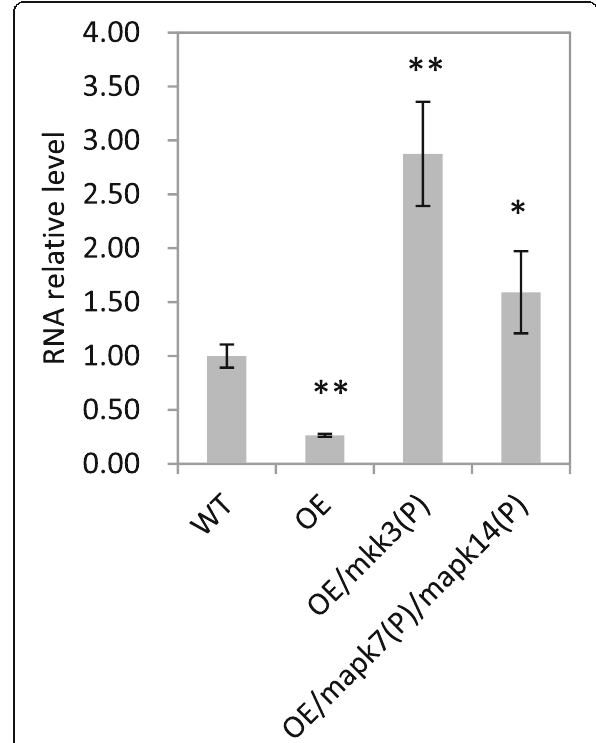
Fig. 6 Relative transcript levels of OsMFT in different transgenic materials. Transcript level of OsMFT was analyzed by real-time PCR using seeds collected at 23 DAH. Values shown are the mean ± SD of triplicate independent biological samples ( n = 3). Transcript level was normalized to that of OsMFT in WT. Student ’ s t -tests were used to generate P values